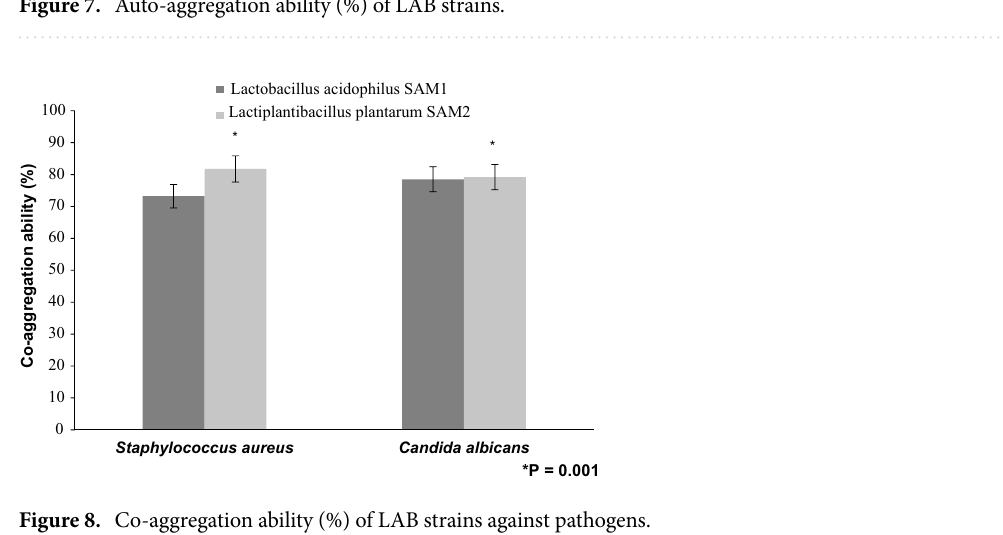
Figure 8. Co-aggregation ability (%) of LAB strains against pathogens.